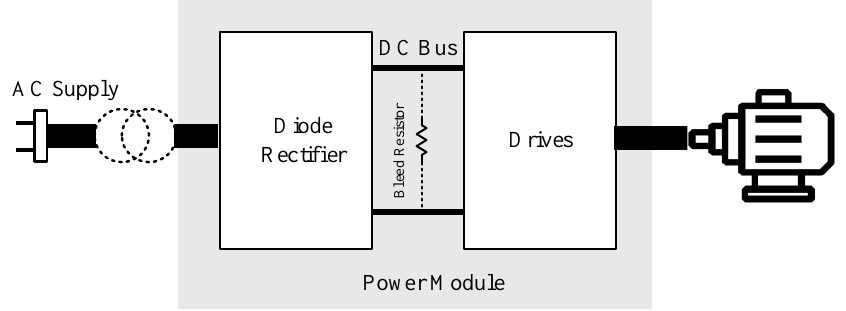
Figure 1. Traditional configuration for low-power servo motor drive application.